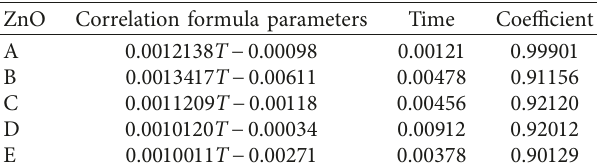
Table 5: Effects of different structures on the refractive index of ZnO